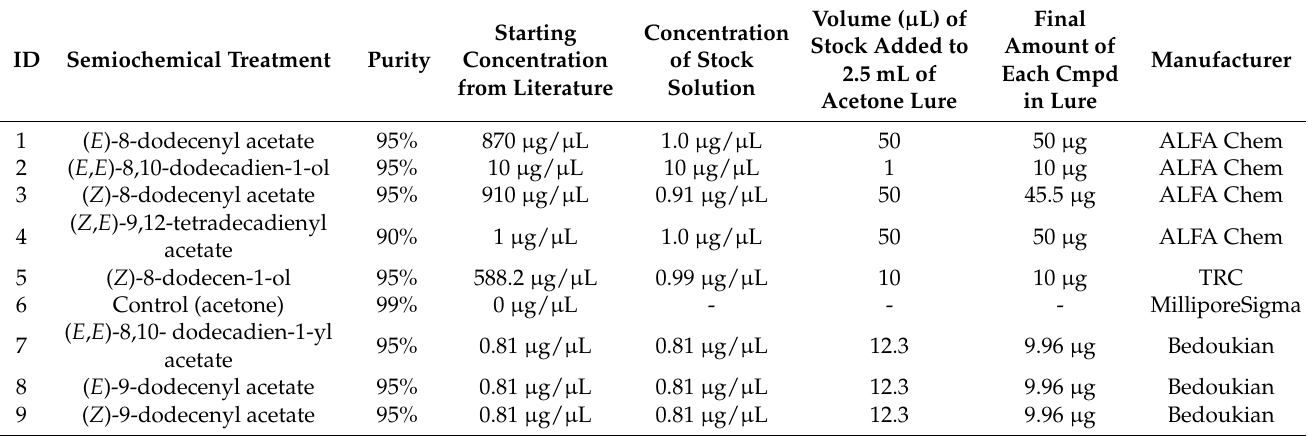
Table 2. Summary of semiochemical treatments and their concentrations in each lure for the field trapping study of E. giganteana at the Land Institute in Salina, KS, USA, in 2019 and